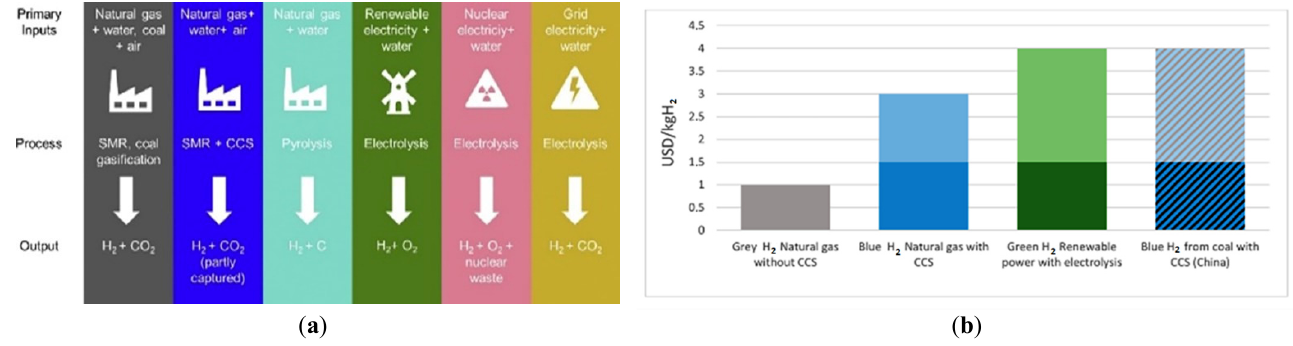
Figure 5. Different hydrogen ( a ) production pathways and ( b ) the estimated cost of blue, grey and green hydrogen production. Reprinted with permission [10,32,33].